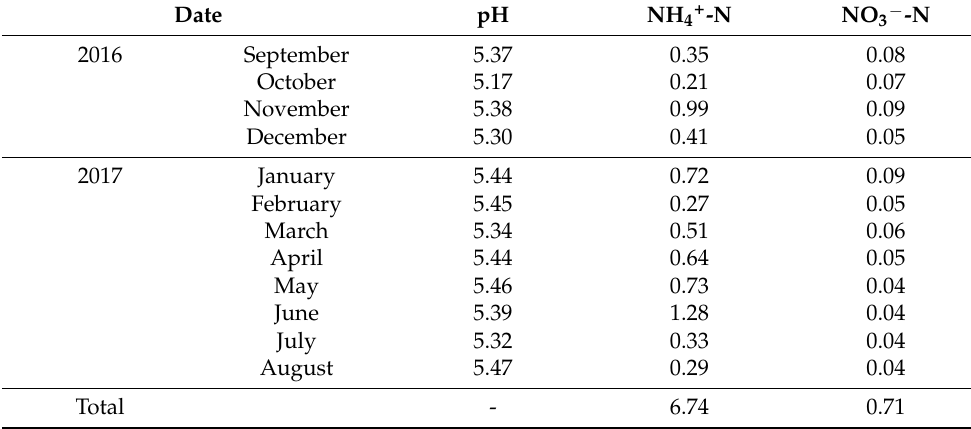
Table 1. Monthly mean pH and the cumulative amount of wet NH 4+ ‐ N and NO 3 − ‐ N (kg ha − 1 ) in rainfall collected in our study site at Sepilok, Sabah, Malaysia.